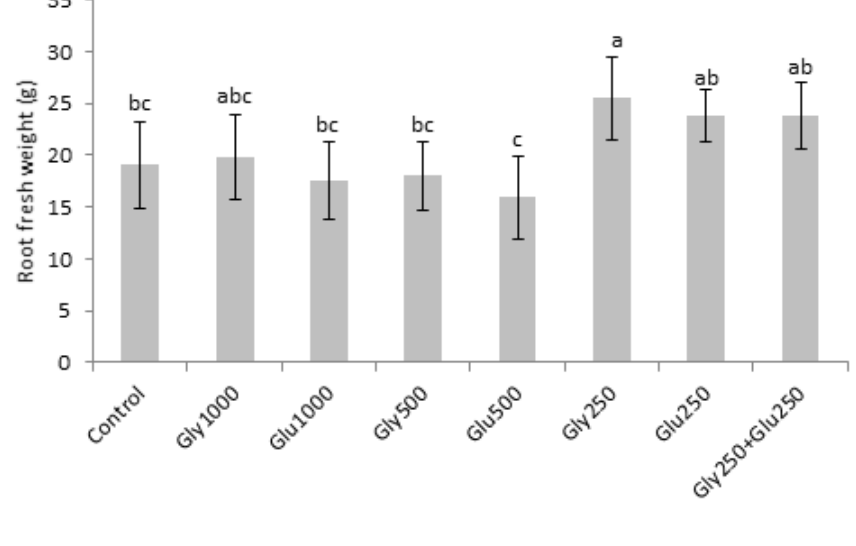
Figure 3: Root fresh weight of lettuce plants under foliar application of glycine and glutamine amino acids. Data are average of four replica- tions ± SD; comparison of means was done at 5% level of Duncan multiple ranges test